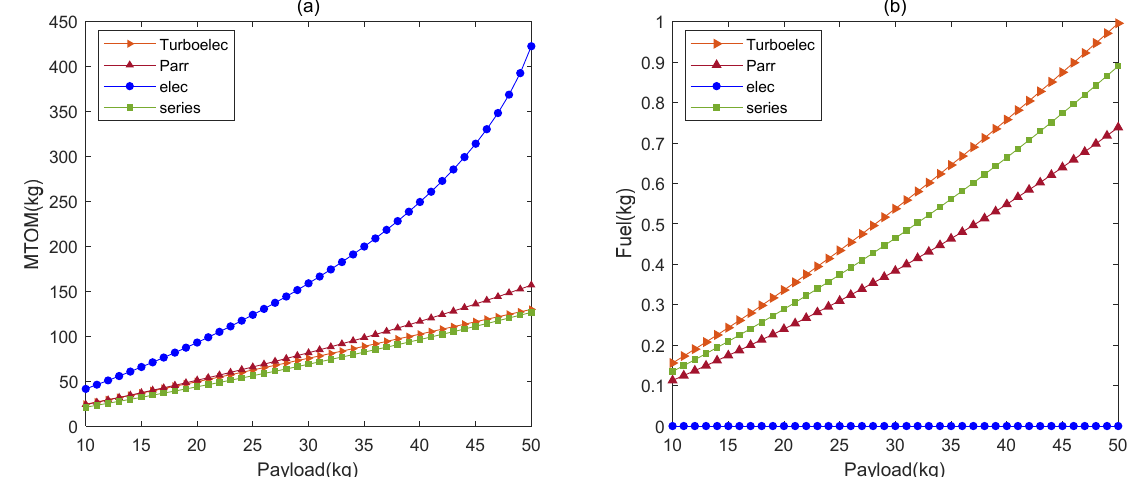
Figure 10. Effect of payload: ( a ) MTOM; ( b ) fuel consumption.